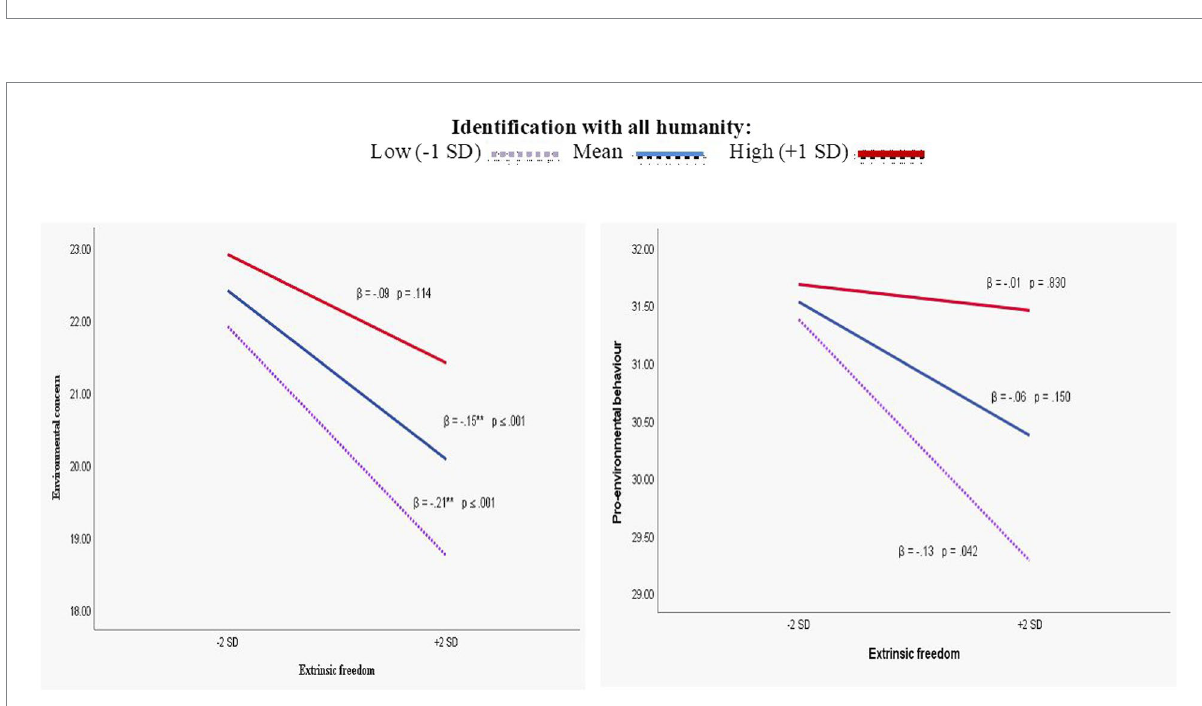
FIGURE 2 Buffering effects of identification with all of humanity on the negative relationship between extrinsic freedom, environmental concern and pro- environmental behavior (Model